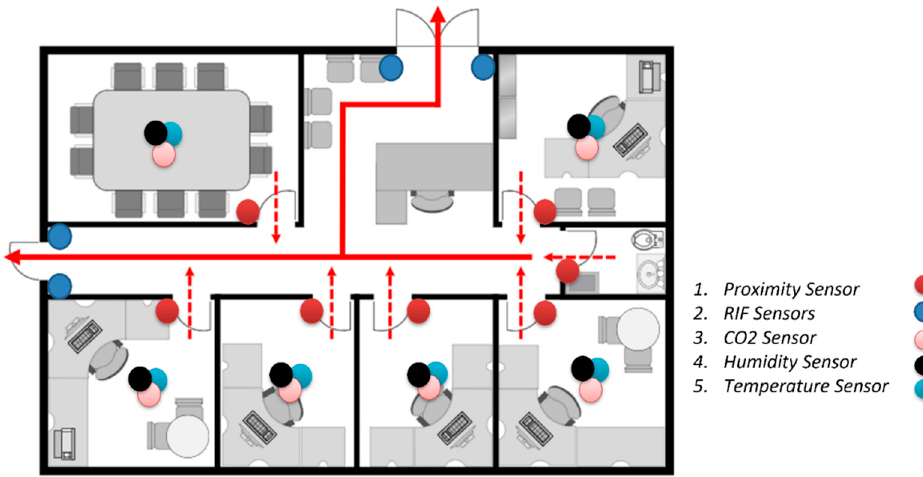
Figure 4. Sensor Deployment architecture in UR, Kalisimbi Block offices.